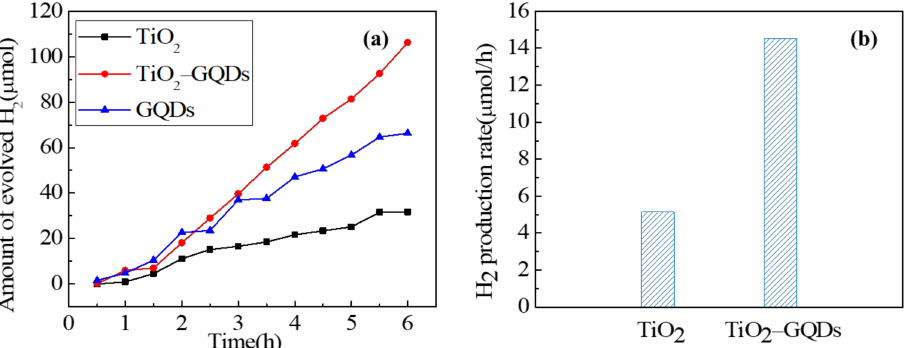
Figure 7. ( a ) Amount of photocatalytic H 2 production, and ( b ) average photocatalytic H 2 production rate for different samples under simulated solar light